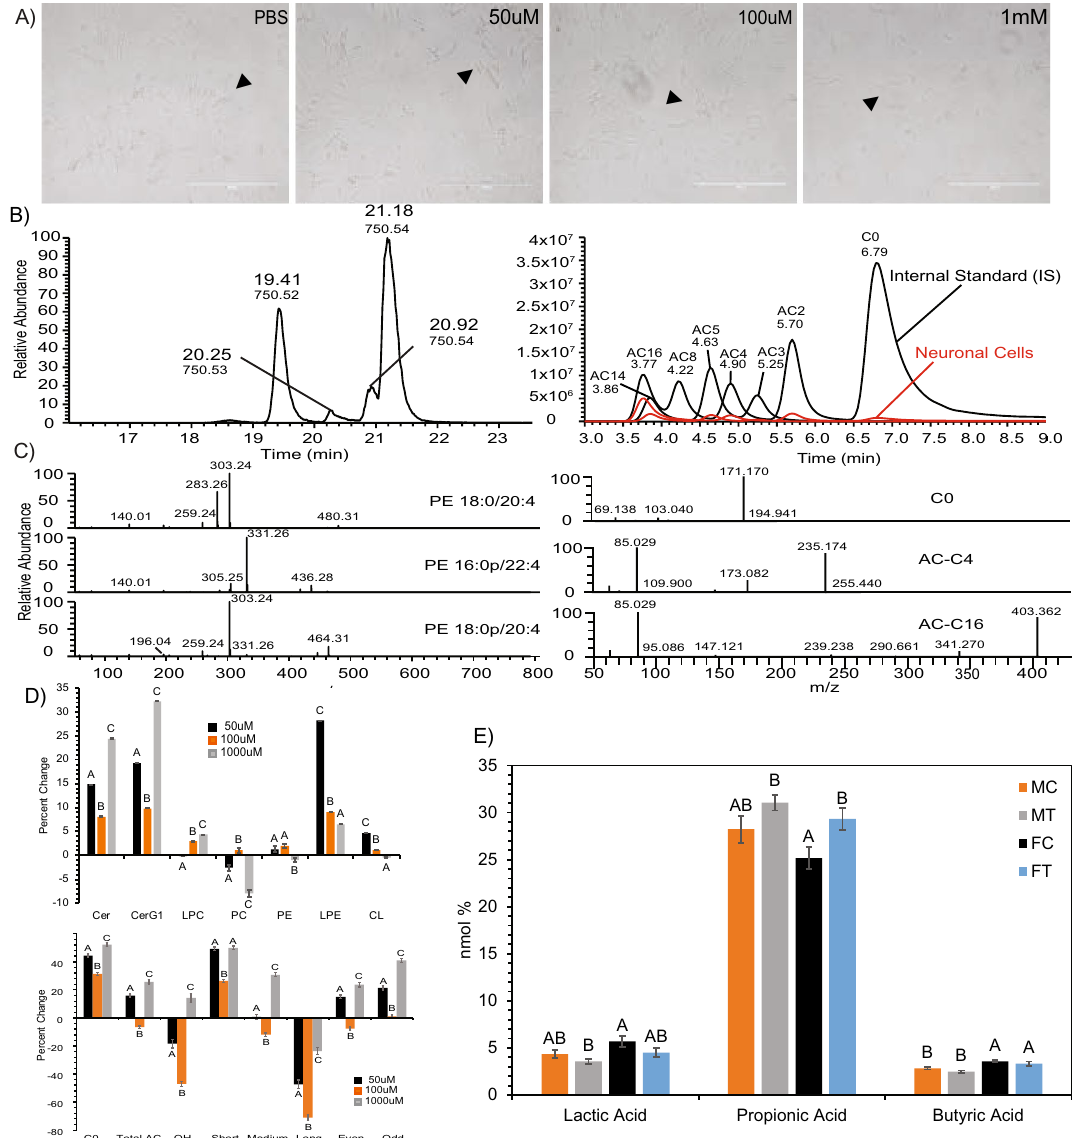
Figure 1. Lipid analysis completed on SH-SY5Y neuronal cells show global alterations due to SCFA treatment. ( A ) Quality of differentiation and neuronal health in control and treated neurons. ( B ) C30RPLC/HILIC extraction ion chromatography example (XIC) in −/+ mode respectively of Phosphatidylethanolamine (PE) (m/ z750) and Acyl Carnitine (AC) lipids found in neuronal cells ( C ) C30RP spectrum identification of PE18:0/20:4, isomers PE16:0p/22:4, PE18:0p/20:4 and HILIC spectrum identification D-labeled carnitine species C0 (free carnitine), AC-C4, and AC-C16. ( D ) Percent change by lipid class of treated neuronal cells vs control for Ceramides (Cer), Glycosylceramide (CerG1), Lyso-Phosphatidylcholine (LPC), Phosphatidylcholine (PC), Phosphatidylethanolamine (PE), Lyso-Phosphatidylethanolamine (LPE), Cardiolipin (CL), Free Carnitine (C0), Total Acyl Carnitine (AC), and OH/short/medium/long/even/odd chained AC. N = 4 samples per treatment group (50 μM, 100 μM, 1000 μM) replicate. ( E ) Alterations in overall acids, including SCFAs, in complementary rat brain study. Bar charts representative of means ± standard error. Means represented by different superscripts are significantly different at p < 0.05. N = 6 per treatment group, M male, F female, C control, T